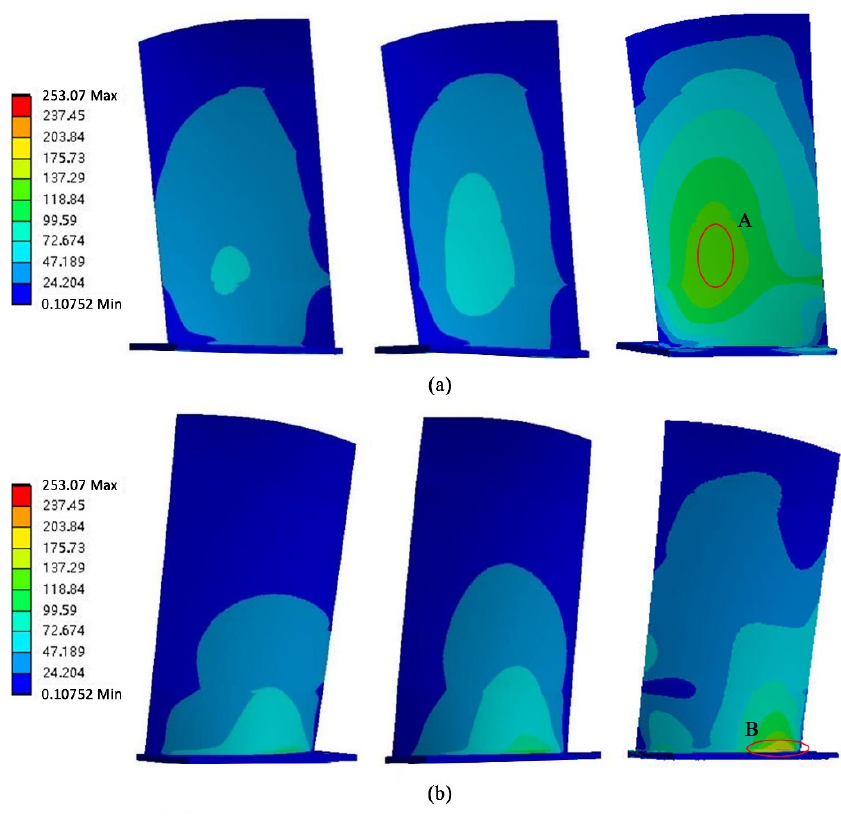
Figure 13. Stress distribution of blade at different time in ground idling condition. ( a ) Pressure side; ( b ) Suction side.